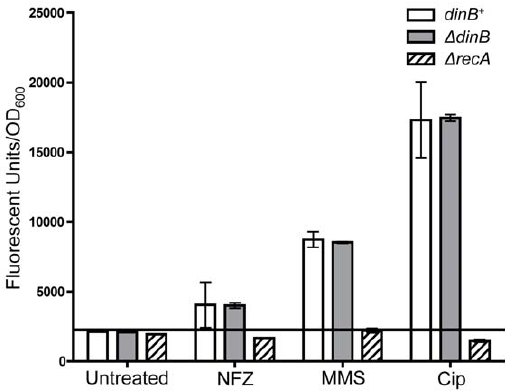
Figure 8. Relative induction of the SOS gene network in cells treated with MMS or NFZ. dinB + , D dinB , and D recA strains carrying a plasmid that expresses GFP from an SOS inducible promoter ( sulA p- GFP) were treated with MMS (7.5 mM), NFZ (0.06 mM shown), or the strong SOS inducer ciprofloxacin (Cip) (0.1 m g/mL) [49]. dinB + and D dinB strains display a significant 50% increase, compared to the control D recA strain, in the ratio of Fluorescence/OD 600 after 2 hours of NFZ treatment and after 1.5 hours of both MMS and ciprofloxacin treatments, 5 hours is shown. For 20 hour kinetic see Fig S2. No increased fluorescence is detected in NFZ concentrations below 0.06 mM (data not shown) when compared to untreated dinB + and D dinB cells, or the D recA negative control during the time frame the experiment was carried out (see Fig S2 for 20 hour kinetic). Error bars represent the standard deviation of the mean from at least 4